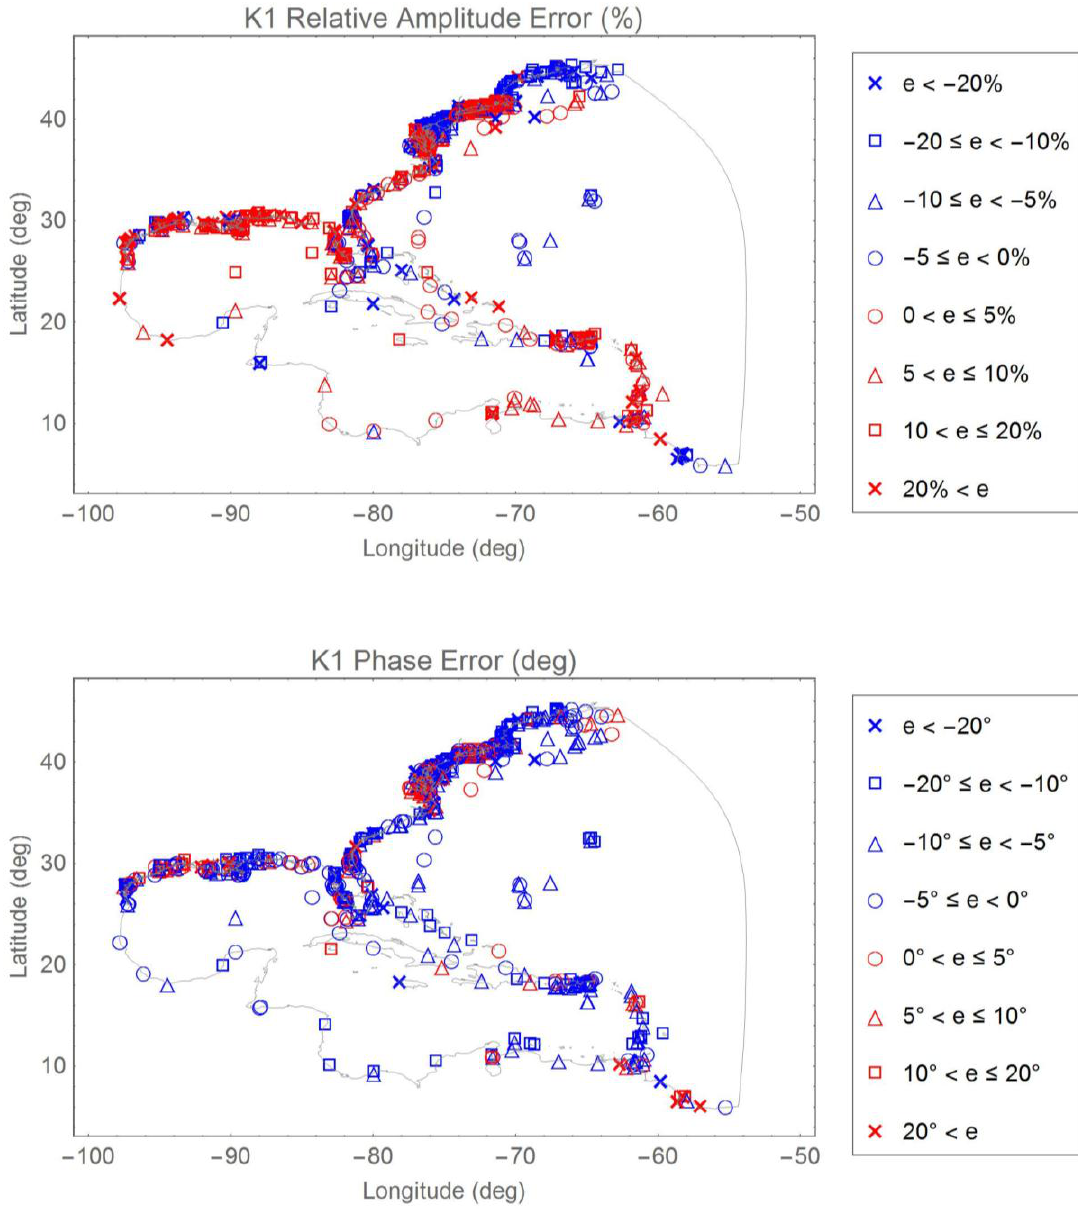
Figure C1. Distribution of relative amplitude and absolute phase errors for the K 1 constituent: global view.